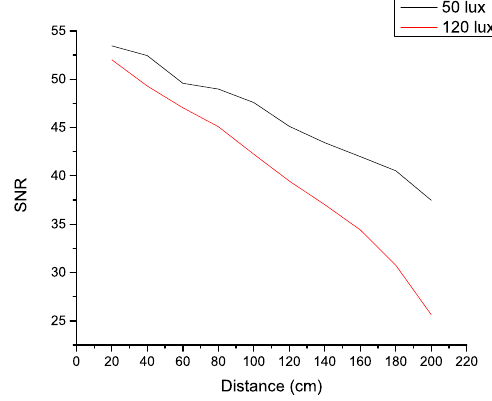
Figure 9. SNR vs. Distance vs. Ambient